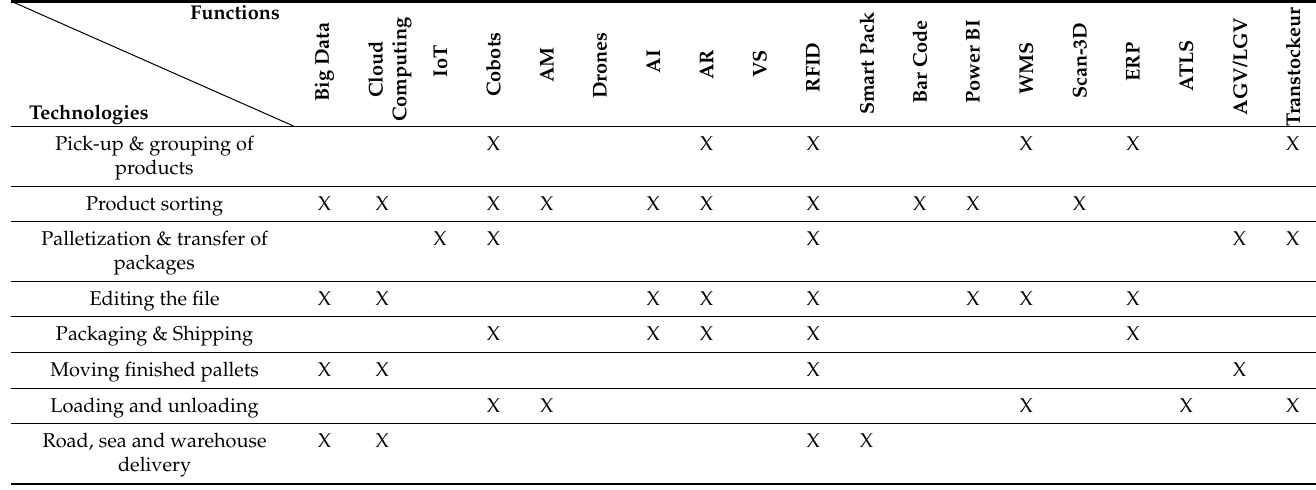
Table 4. Assignment and adaptability of technologies to process functions.